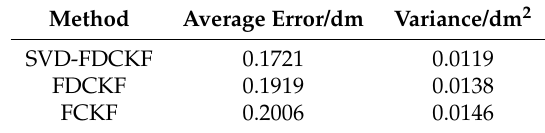
Table 3. The average error and variance of SVD-FDCKF, FDCKF, and